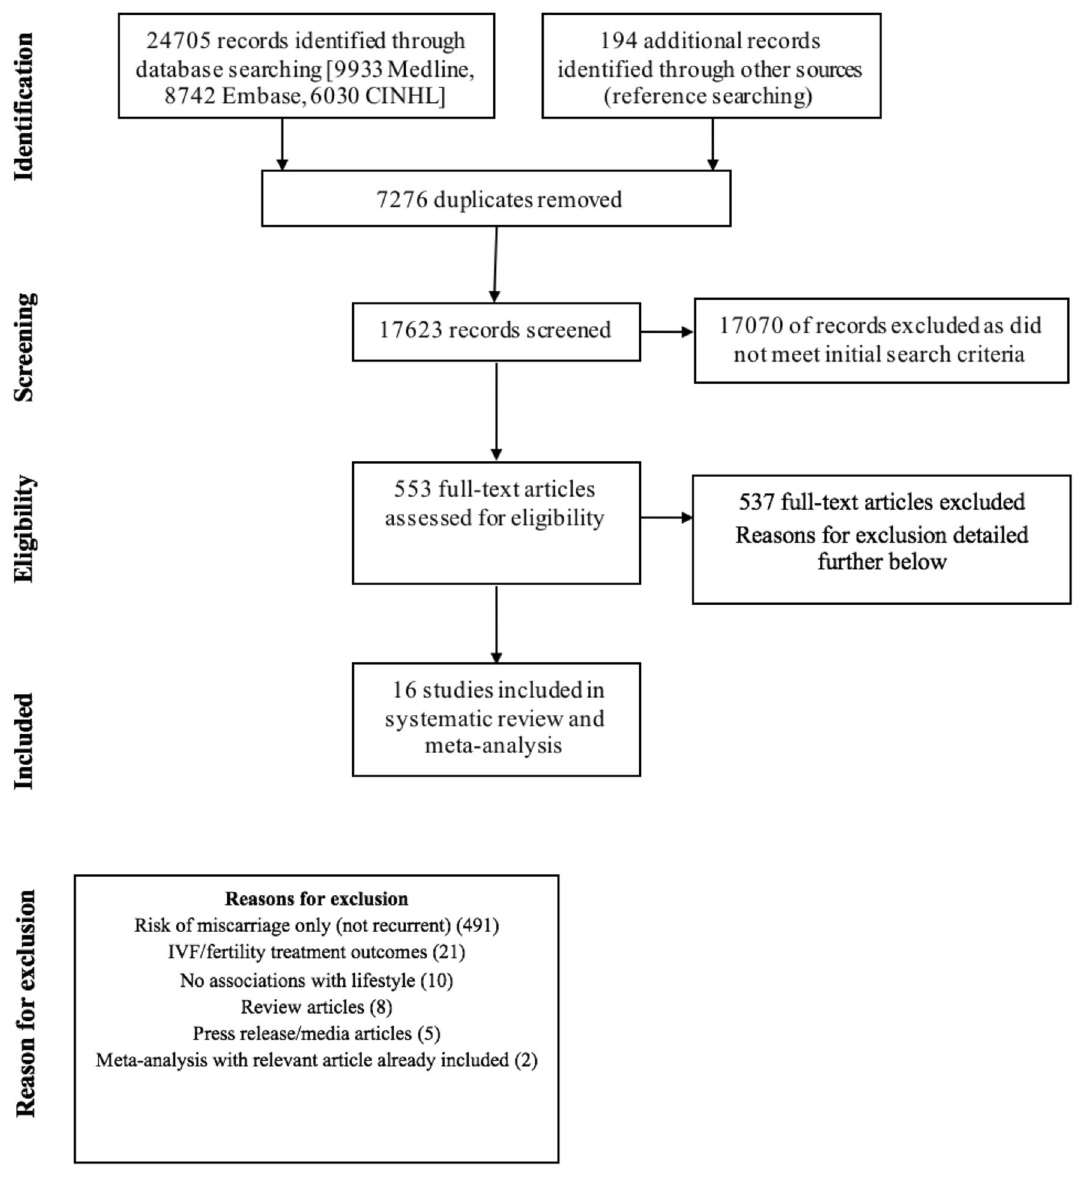
Figure 1. PRISMA flow diagram detailing search results 11